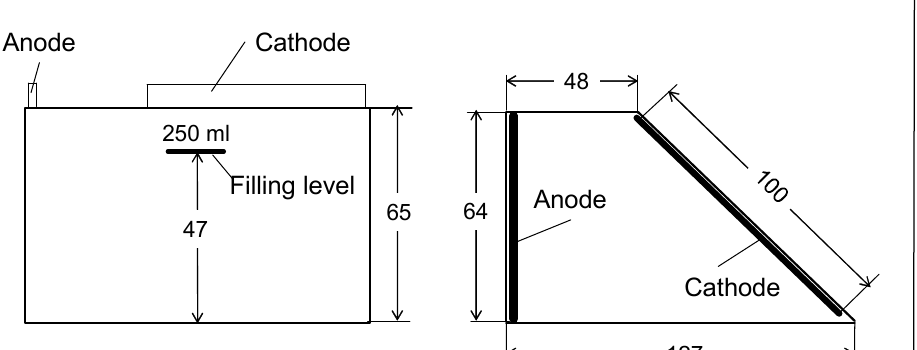
Figure 1 – Principle of work for the Hull cell (Volume of 250 ml) Рис . 1 – Принцип работы ячейки Хулла ( на объем 250 мл ) Slika 1 – Princip rada Hulove ć elije (zapremine 250